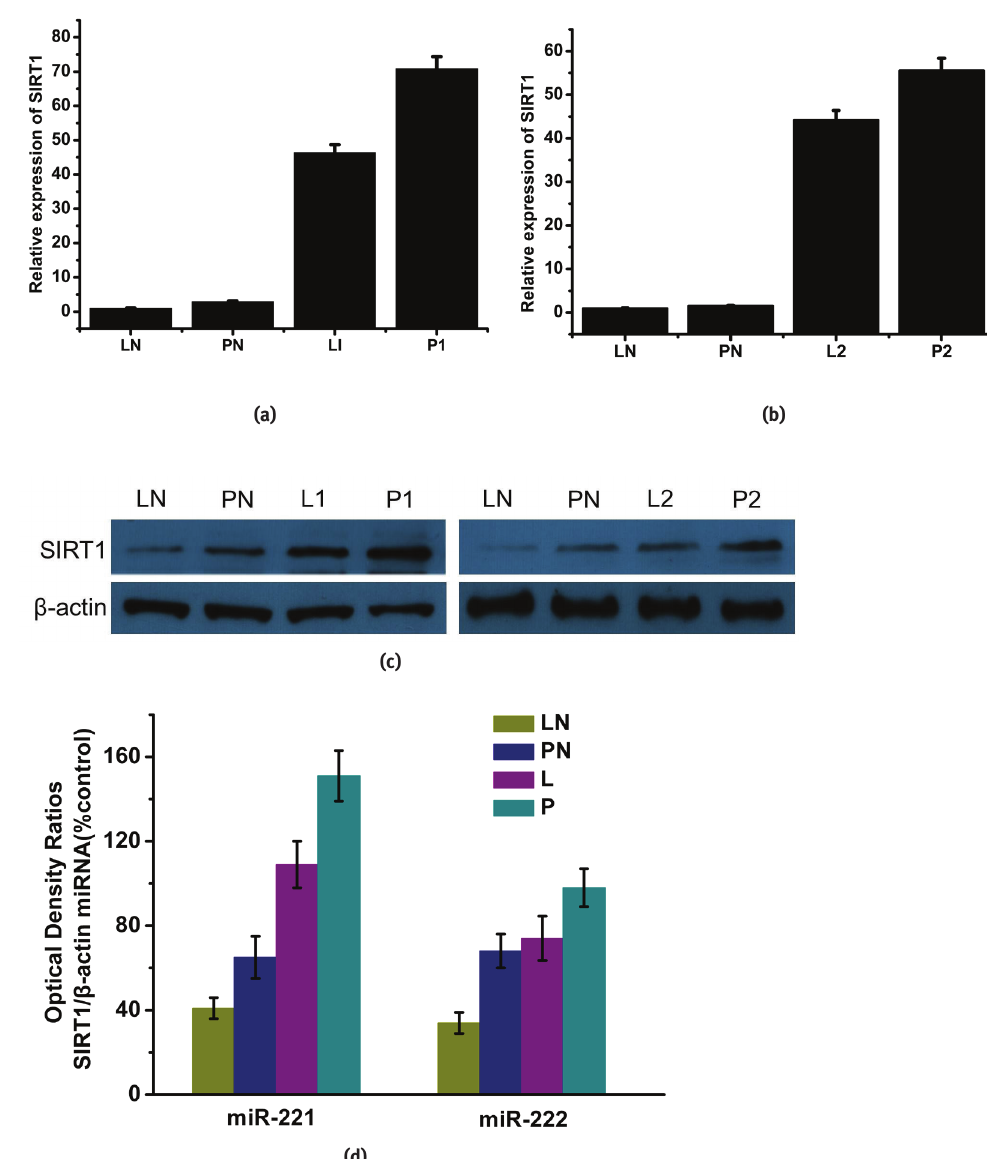
Figure 8: (a) Figure of SIRT1 gene expression in PC-3 cells by RT-PCR.(miR-221 group). (b) Figure of SIRT1 gene expression in PC-3 cells by RT-PCR.(miR-222 group) LN: blank group; PN: PEG-PEI/miR-scr group; L1: lipo2000/miR-221 group; P1: PEG-PEI/miR-221 group; L2: lipo2000/miR-222 group; P2: PEG-PEI/miR-222 group. Dose of miR: 100nM; polyplexes were synthesized at N/P=20; data are mean±SD (n=3). (c) Analysis of SIRT1 expression at protein level by western blot. (d) The densitometric data of western blot LN: blank group; PN: PEG-PEI/miR-scr group; L:lipo2000/miR-221 group (lipo2000/miR-222 group); P: PEG-PEI/miR-221 group (PEG-PEI/miR-222 group). Dose of miR: 100nM; polyplexes were formed at